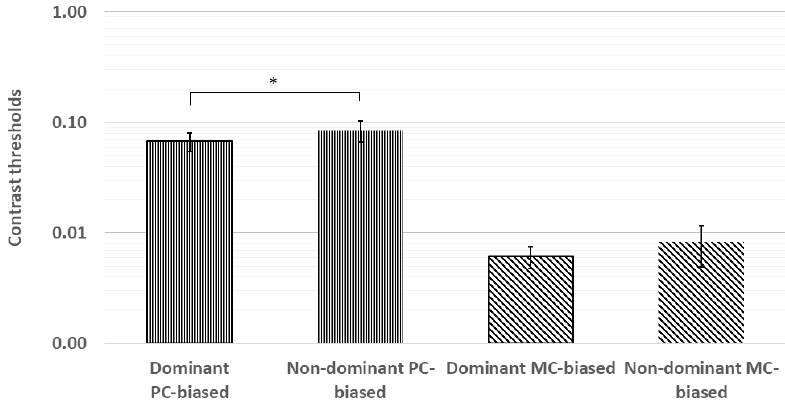
Figure 4. The planned paired comparisons of contrast thresholds revealed significantly lower thresholds in the dominant eye for the PC-biased stimulus but not for the MC-biased stimulus. * p < 0.05; error bars represent ±1 standard deviation.